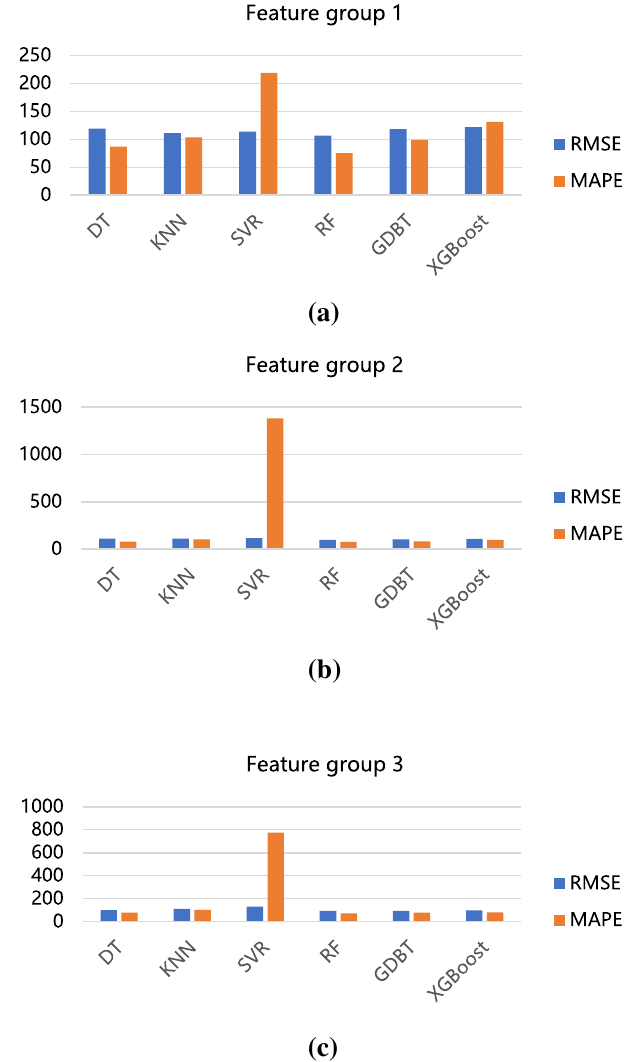
Figure 9. Comparison of model errors with RMSE and MAPE. ( a ) The input variable of feature group 1, ( b ) The input variable of feature group 2, ( c ) The input variable of feature group 3.